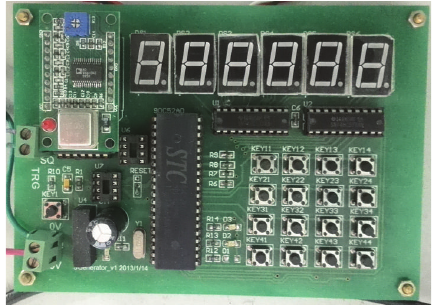
Figure 6: DDS frequency generation with MCU.